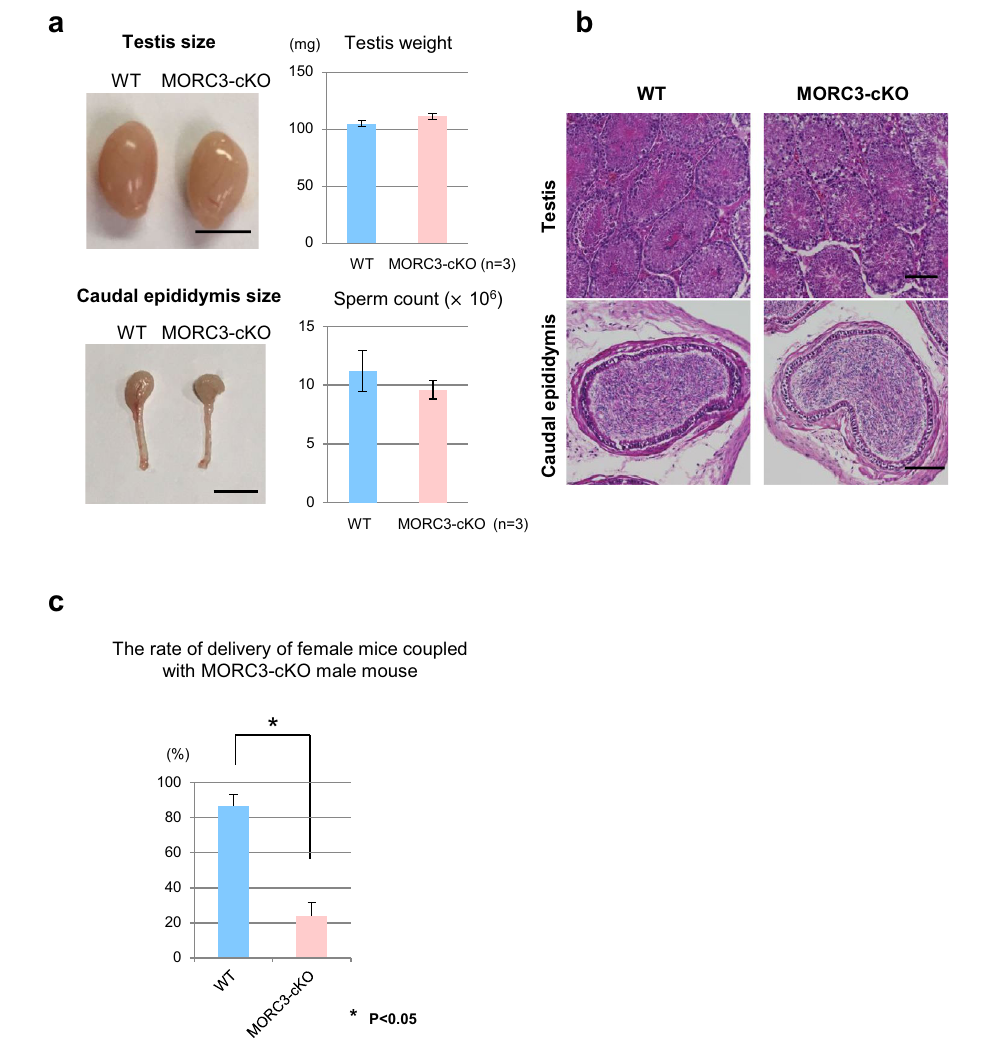
Figure 2. Subfertility of the MORC3 mutants. ( a ) Testes and caudal epididymis in the wild type and MORC3- cKO mice (left). Testis weights and sperm count in individual mice (right). Error bars denote SD. Scale bar, 5 mm. ( b ) HE staining of the testes and caudal epididymis of 8-week-old wild type and MORC3-cKO mice. Scale bar, 100 μm. ( c ) The percentage of delivery by female mice that mated with the MORC3-cKO male mice. Error bars denote SD. A significant difference (* p < 0.05 by the t test) between wild type and MORC3-cKO data is